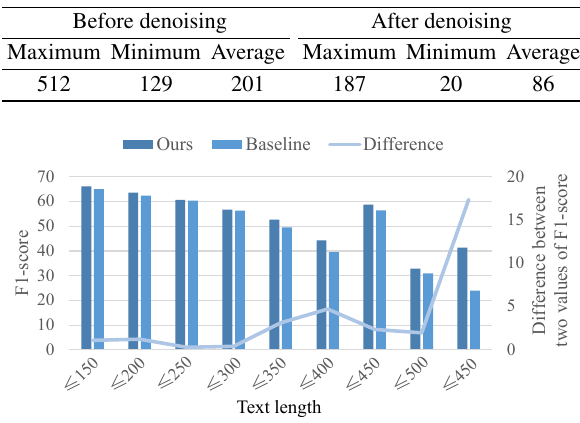
Table 6 Document lengths before and after denoising.